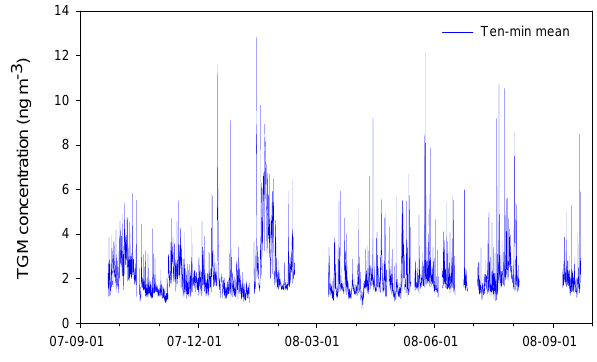
Fig. 2. Time series of the distribution of TGM concentrations in ambient air at Mount Waliguan Observatory Baseline.